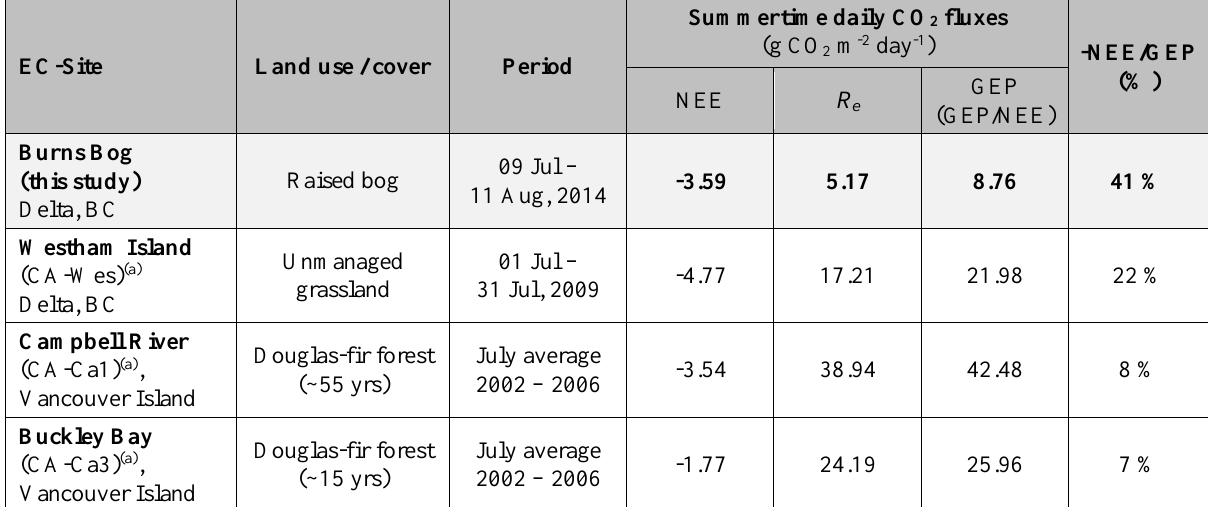
Table 6. Comparison of summertime net ecosystem exchange (NEE), ecosystem respiration ( R e ) and ecosystem photosynthesis (GEP), over different vegetated land covers in the Vancouver region where EC measurements of CO 2 fluxes have been carried out. Entries are sorted by decreasing -NEE/GEP ratio.